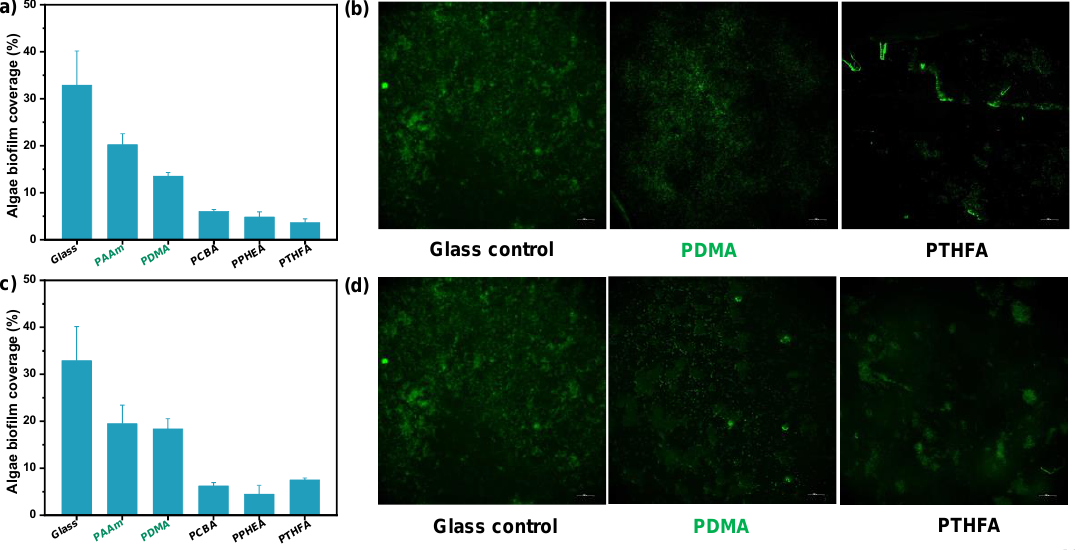
Figure 6. E. coli bacteria biofouling evaluation of typical hydrogels obtained by the solvent exchange of organo-gels with equilibrium state in DMSO after incubation of 168 h in E. coli suspension. ( a ) Image analysis results (% biofilm coverage) of various surfaces: statistical analysis of the mean fluorescence intensity. ( b ) Typical fluorescence microscopy images of E. coli biofouling on hydrogels.